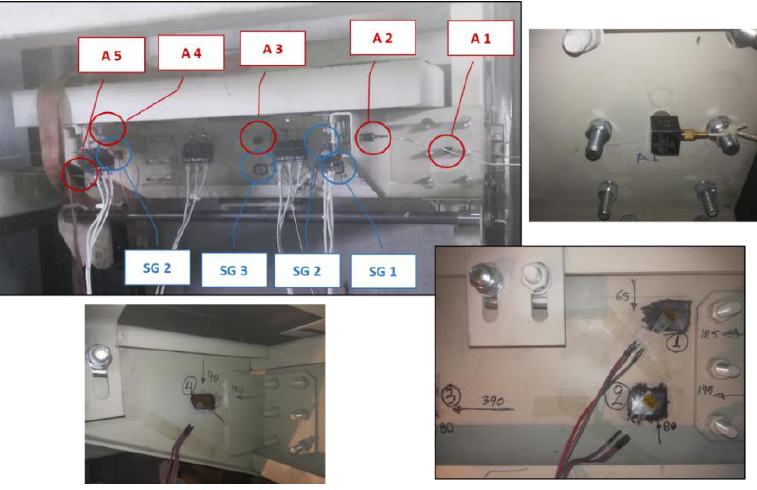
Figure 7. Strain gauges and accelerometers located on the in situ test-case chassis.